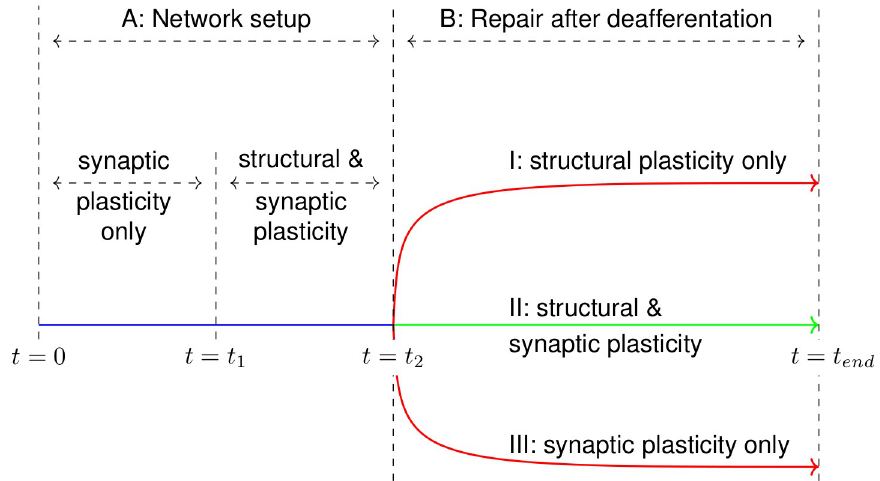
Fig 14. The simulation runs in 2 phases. Initially, the set-up phase (0 s < t < t 2 ) is run to set the network up to the balanced AI state. At ( t = t 2 ), a subset of the neuronal population is deafferented to simulate a peripheral lesion and the network is allowed to organise under the action of homeostatic mechanisms until the end of the simulation at ( t = t Each homeostatic mechanism can be enabled in a subset of neurons to analyse its effects on the network after deafferentation.